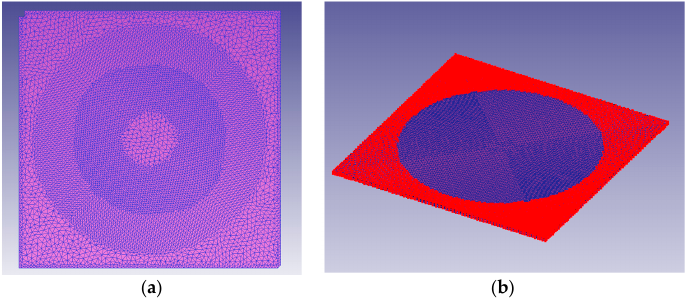
Figure 5. ( a ) Meshing zones considered and ( b ) boundary conditions (clamped condition in “red”).